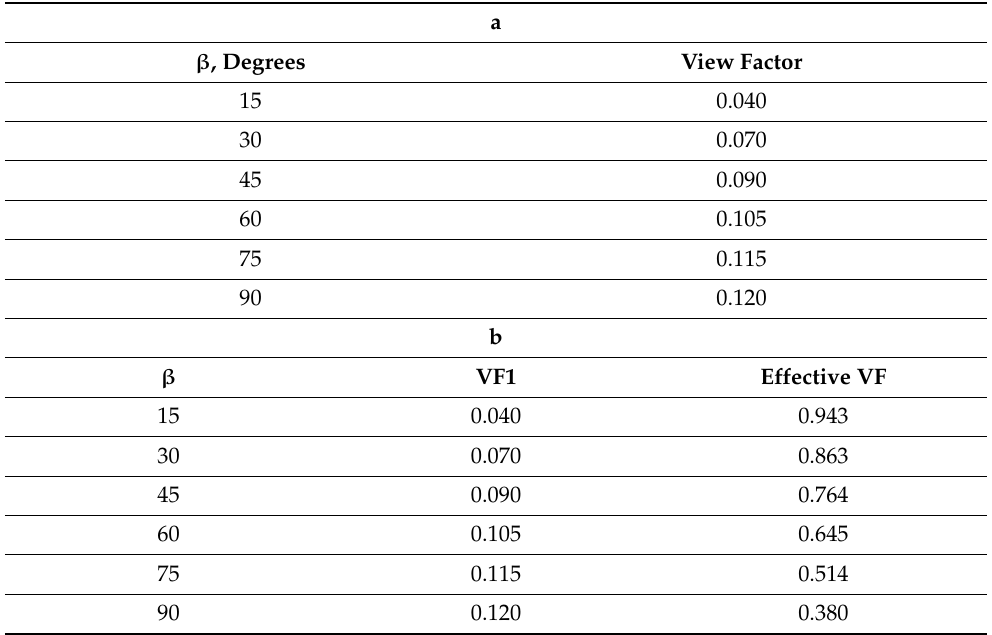
Table 2. a . View factor between two parallel PV modules. The length and width of the module are 2 and 1 m, respectively, and the distance between the modules is 2 m. b . Effective view factor between the sky and the module.